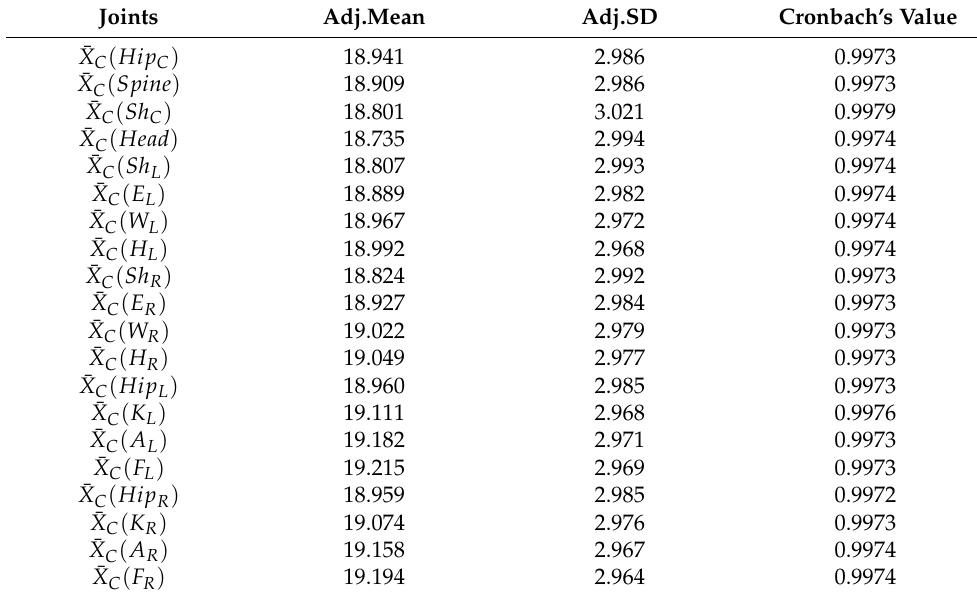
Table 5. The results of adjusted mean (Adj.mean), adjusted standard deviation (Adj.SD), and Cron- bach’s alpha for reliability of human body